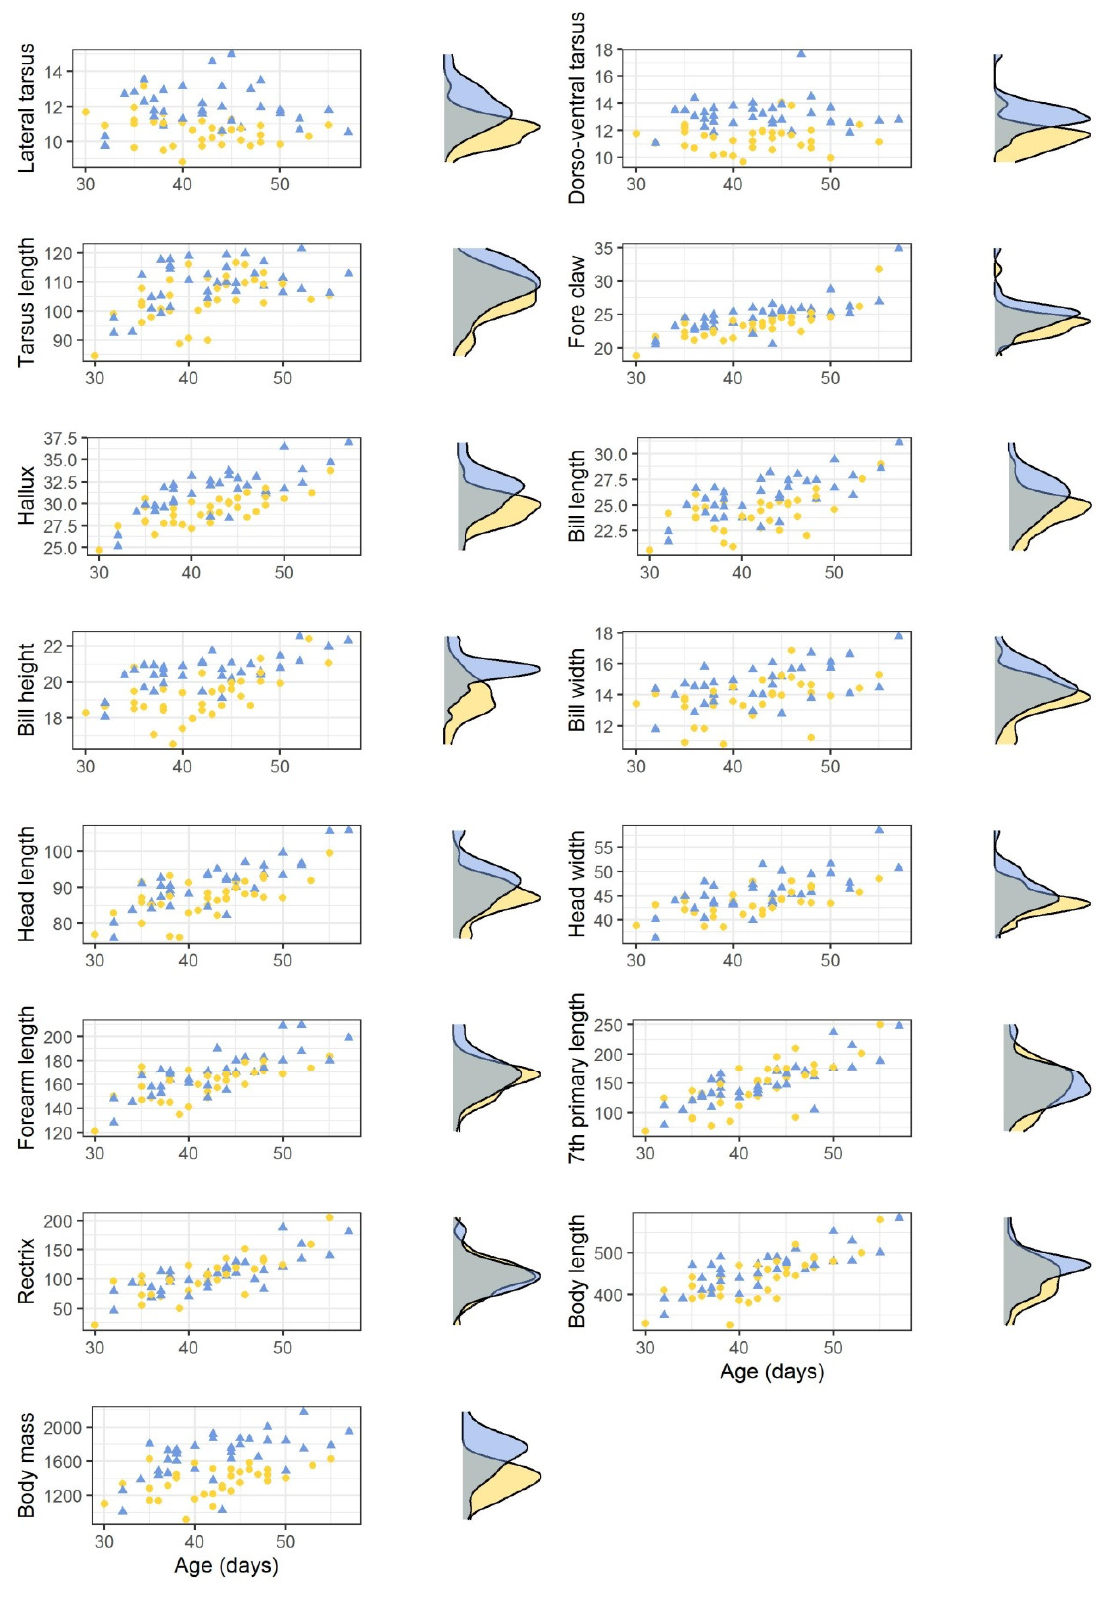
Figure 1. Morphometrics of male (yellow dots, n = 34) and female (blue triangles, n = 34) Bonelli’s eagle nestlings from eastern Spain sexed by molecular techniques. Measurements are given in mm and nestlings’ age in days. Density plots are shown to the right of each fi gure.